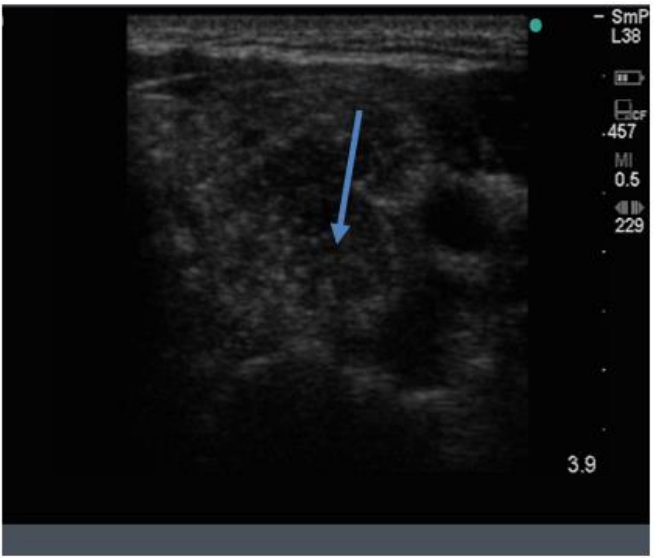
Figure 11. Thyroid ultrasound from a patient with confirmed papillary thyroid cancer. The nodule is large (3 cm) and hypoechoic with an indistinct irregular edge and central microcalcifications.